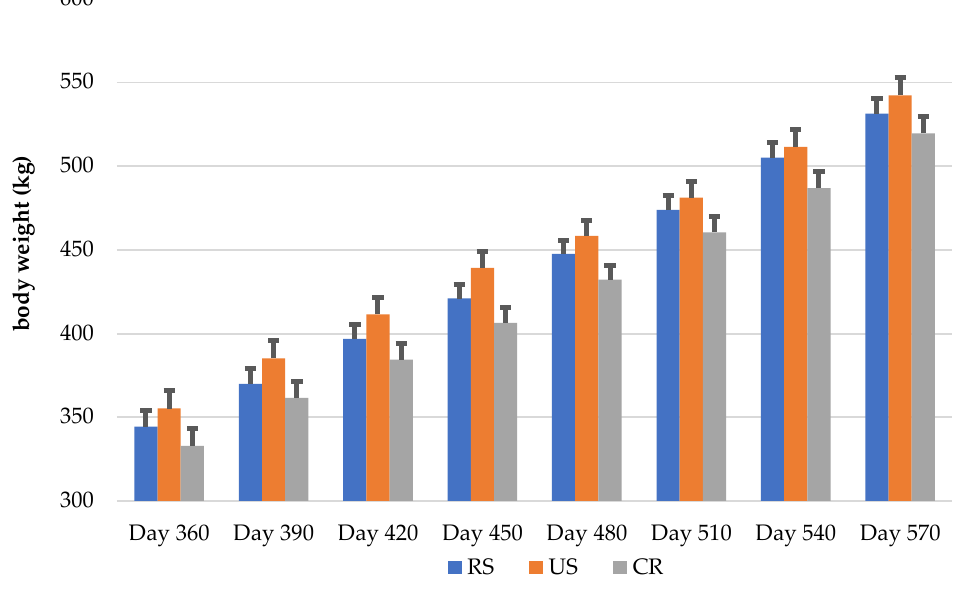
Figure 2. Growth of the live body weight of heifers (kg).